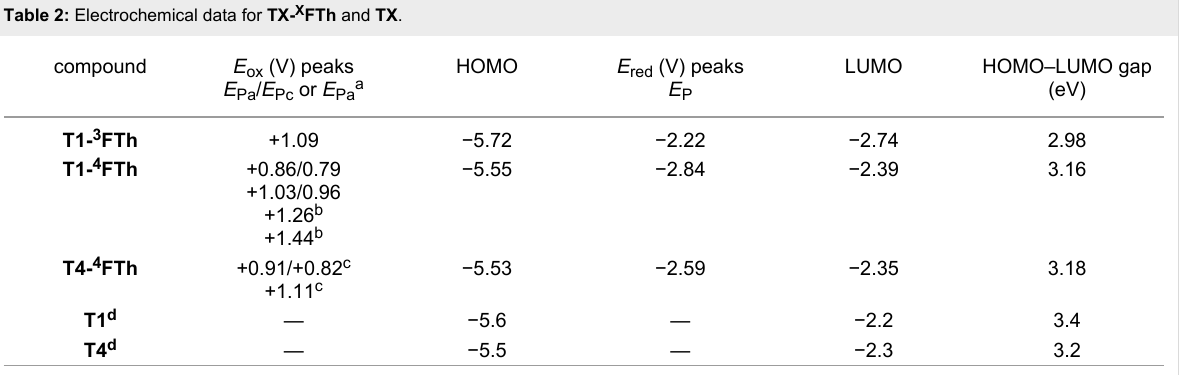
to the terminal positions on the arms leads to a red shift for both absorption and emission. The red shift within the 4 FTh -substi- tuted series ( T1- 4 FTh and T4- 4 FTh ) increases with increasing chain length. The emission spectrum for T1- 4 FTh also shows a pronounced vibronic feature at 418 nm, which is an indication of the planarity of the molecular ground state in comparison to that of T1- 3 FTh , where no vibronic splitting is observed.